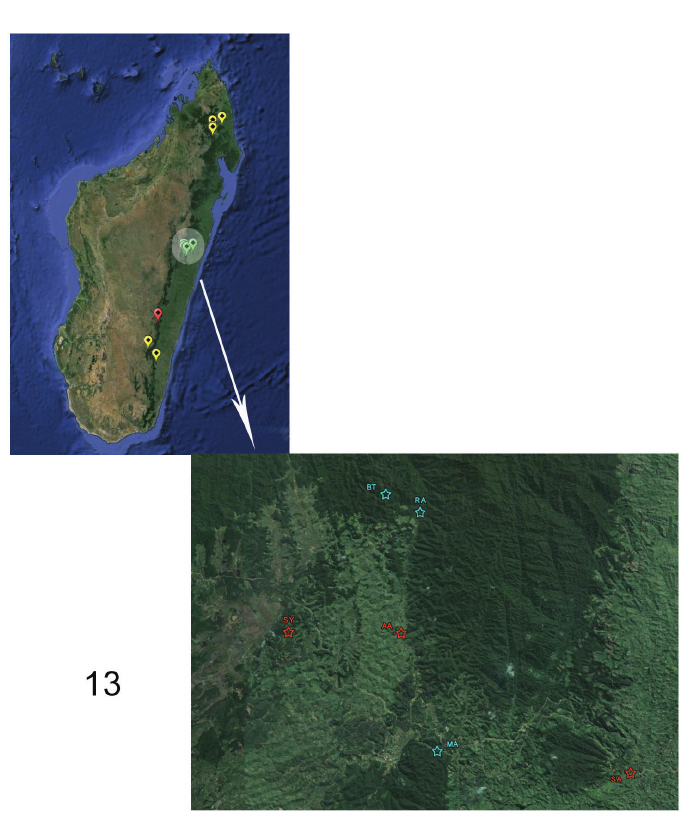
Figure 13. Map of known specimens of M. keiseri , with detailed map of the Andasibe area. Yellow pins: new localities; red pin: type locality (Ranomafana); green pins: localities in Andasibe area. Code of the localities according to Table